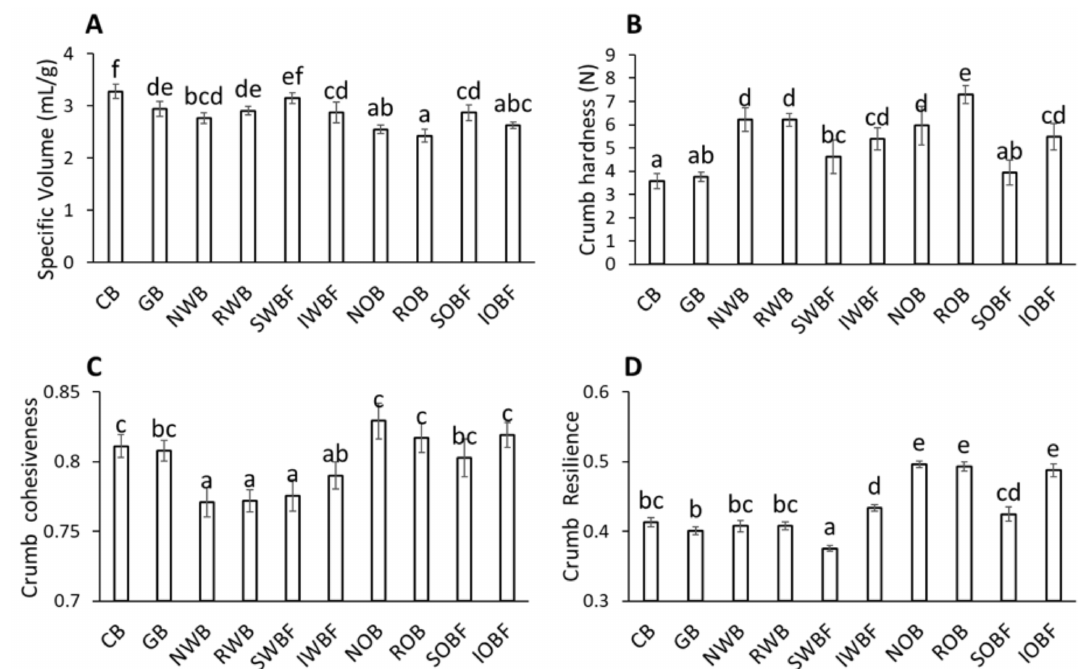
Figure 6. Bread quality parameters for breads obtained with enrichment in bran and bran fractions and glass beads: specific volume ( A ), crumb hardness ( B ), crumb cohesiveness ( C ), and crumb resilience ( D ). Sample abbreviations are reported in Table 1. Different letters in the bar charts indicate statistically significant differences ( p <